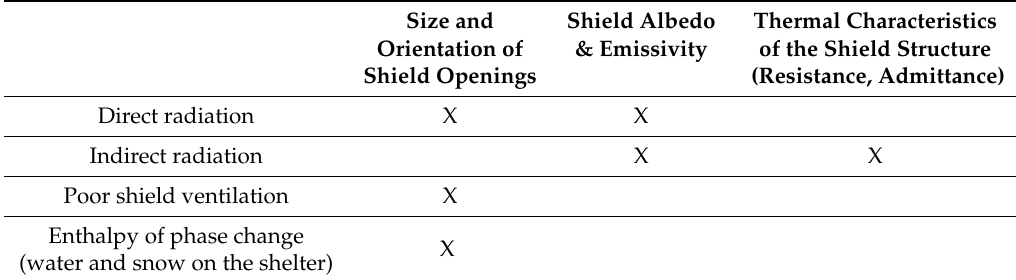
Table 1. Shelter characteristics and physical phenomena that lead to measurement error of the air temperature. Size and Shield Albedo Thermal Characteristics Orientation of & Emissivity of the Shield Structure Shield Openings (Resistance, Admittance) Direct radiation X X Indirect radiation X X Poor shield ventilation X Enthalpy of phase change X (water and snow on the